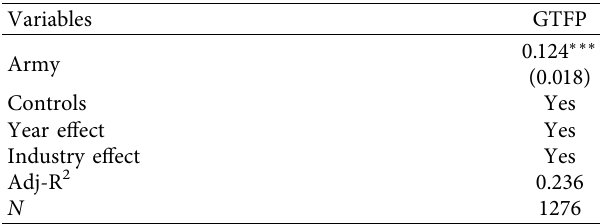
Table 5: Propensity score matching (PSM) regression results.